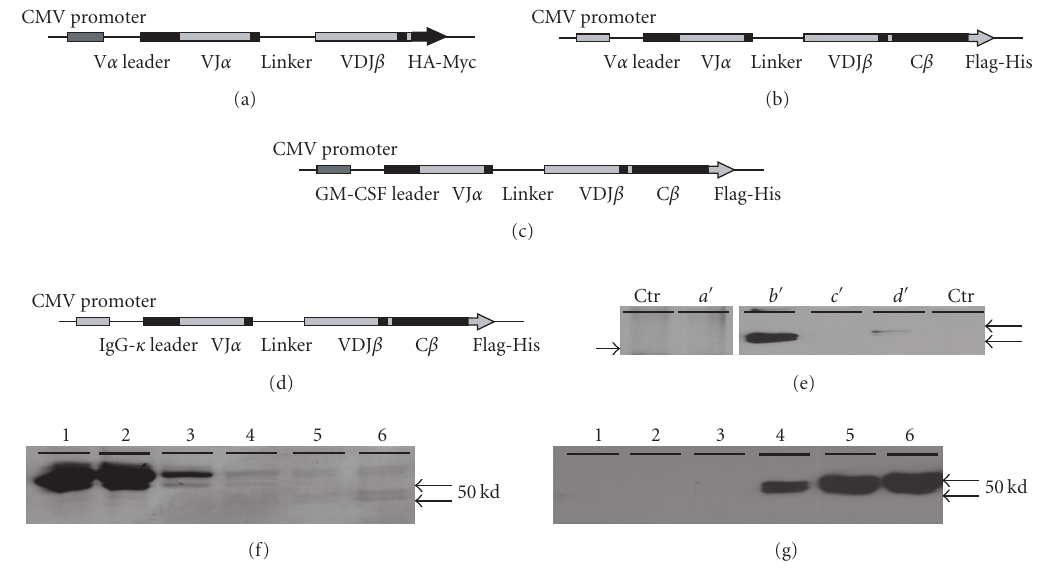
Figure 6: Expression and purification of soluble scTR using mammalian expression system . (a) The single-chain fraction variable (scFv) domain was cloned and fused to a C-terminus HA and c-myc epitope tags. (b) Secreted scTCR that was cloned and fused to a C-terminus Flag and 6-His epitope tags. (c) and (d) the secreted scTR as described in (b), with the exception that the secreted scTR was fused to the leader sequence from GM-CSF (c) or from Ig- κ light chain (d). (e) Western blot of the culture supernatants from 293H cells transiently transfected with constructs a–d (a (cid:2) –d (cid:2) ), immunoprecipitated with appropriate anti-tag antibody and blotted with anti-c-myc antibody (a (cid:2) ) or with anti- Flag-M2 antibody (b (cid:2) –d (cid:2) ). Ctr is supernatant from untransfected cells. (f) Coomassie blue staining of fractions from culture supernatant b (cid:2) purified using nickel column. Lane 1 is culture supernatant before purification, 2 is flow through, 3 is wash, and 4–6 are di ff erent eluted fractions. (g) Western blot of panel (f) using anti-Flag M2